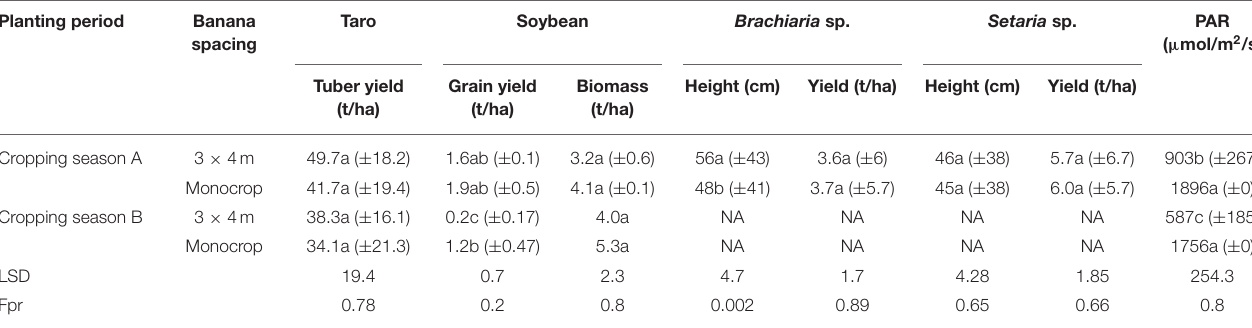
TABLE 5 | Yield and growth attributes of crops grown at Kavumu: tuber crop taro (variety “Astrida”), legume crop soybean and forage grasses Brachiaria sp. and Setaria sp. Planting period Banana Taro Soybean Brachiaria spacing